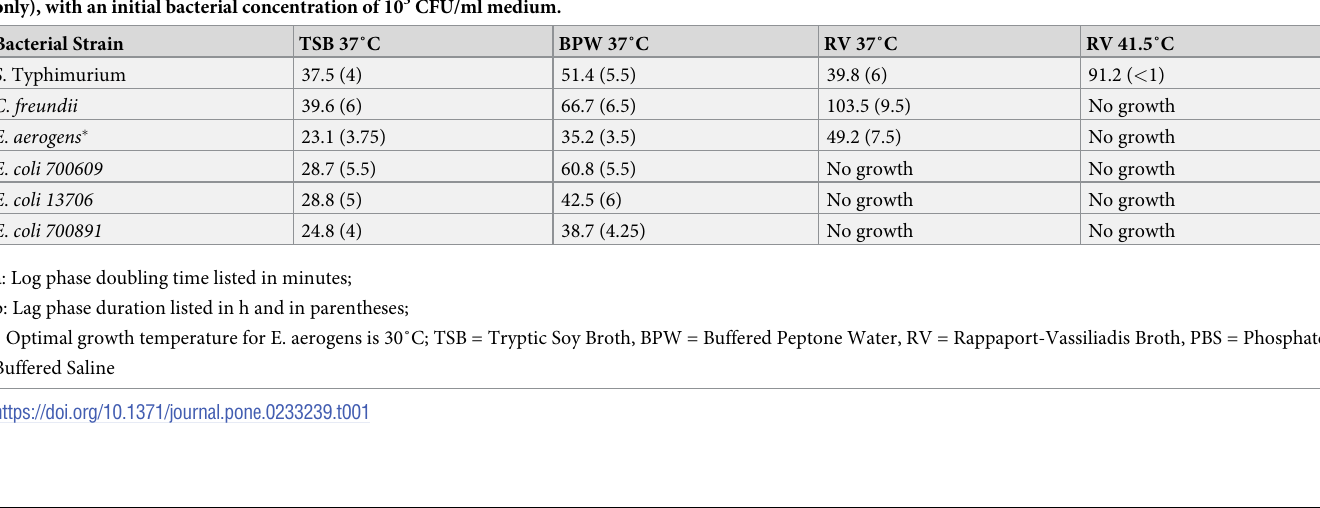
Table 1. Generation time a and lag phase duration b of the tested bacteria in different culture broth medium (TSB, BPW and RV broth) at 37˚C or 41.5˚C (RV broth only), with an initial bacterial concentration of 10 3 CFU/ml medium. Bacterial Strain TSB 37˚C BPW 37˚C RV 37˚C RV 41.5˚C 37.5 (4)